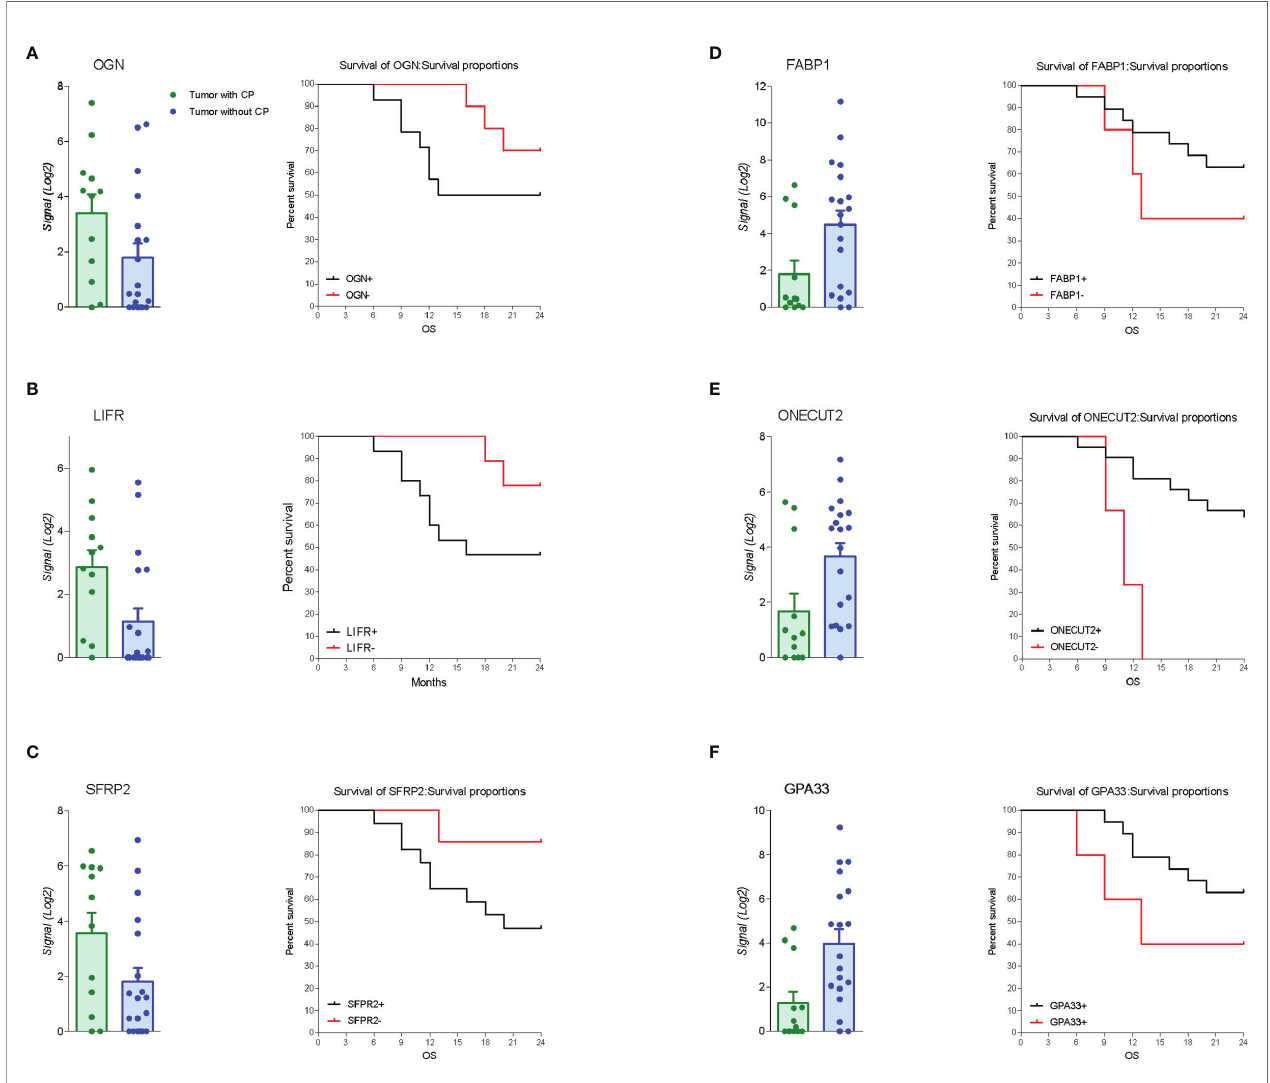
FIGURE 3 | Gene expression and survival curve. Left panel: Relative mRNA expression levels extract from RNA-seq analysis and overall survival of patients according to up regulated genes expression of (A) OGN, (B) LIFR, and (C) SFRP2. Right panel: Relative mRNA expression levels extract from RNA-seq analysis and overall survival of patients according to down regulated genes expression of (D) Fabp1, (E) Onecut2, and